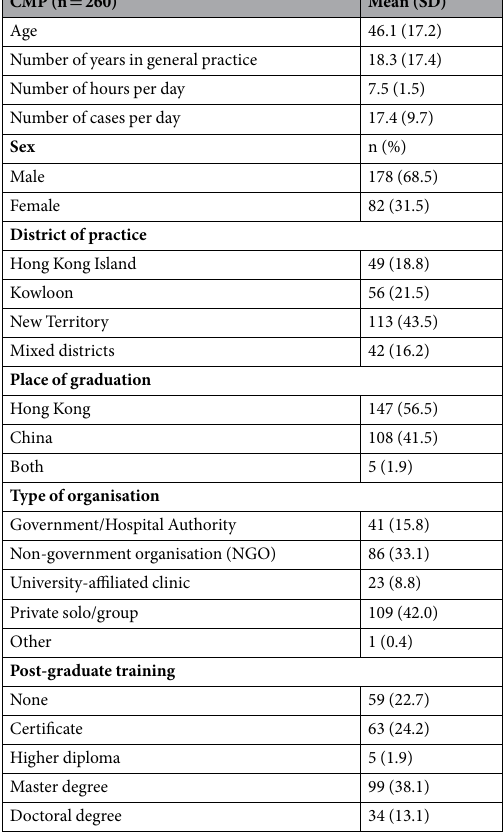
Table 1. Characteristics of Chinese medicine practitioners who participated in the morbidity